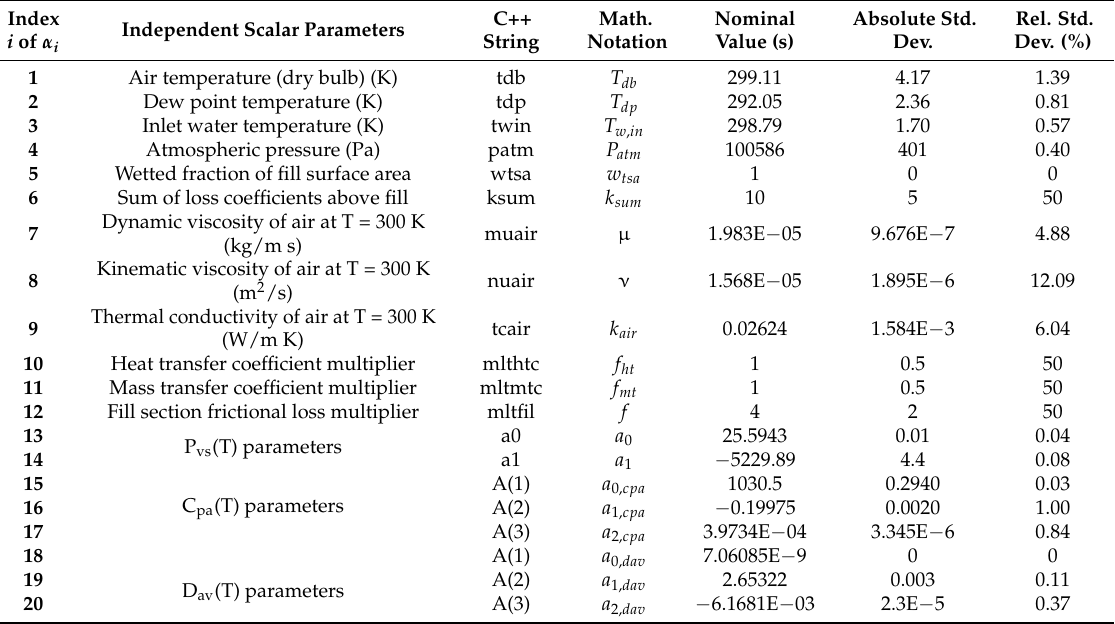
Table B1. Parameters for SRNL F-area Cooling